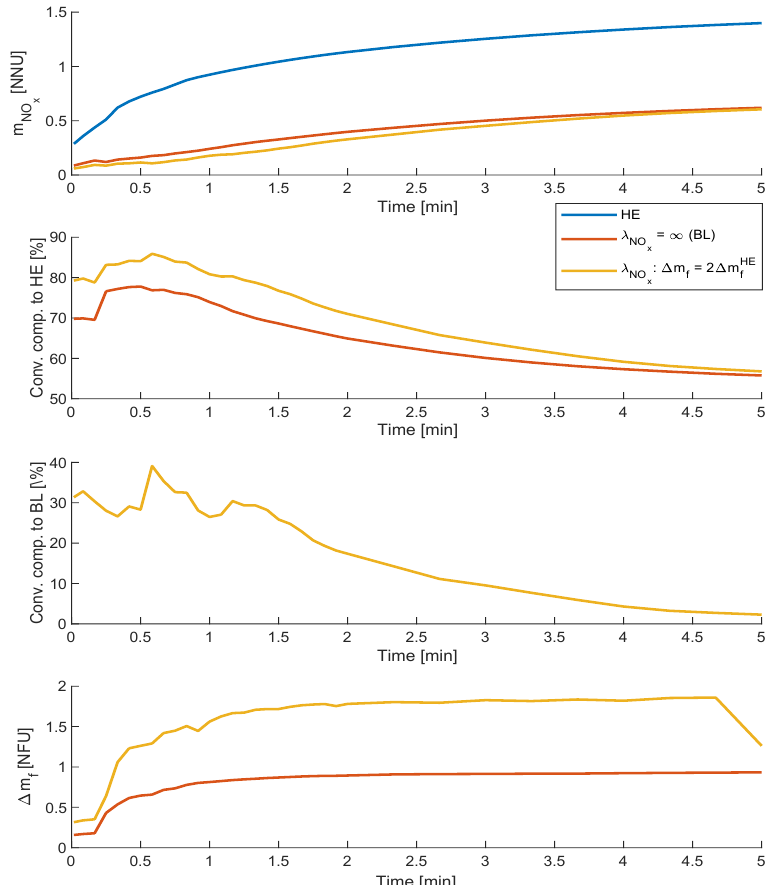
Figure 9. The same as Figure 8, but here λ NO double that of the baseline strategy.